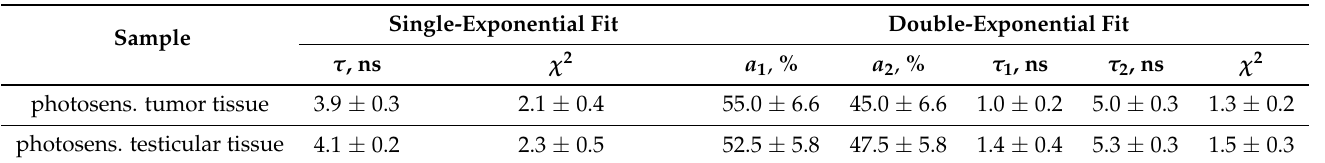
Table 1. Characteristic decay times and amplitudes of fluorescence determined by the single- and double-exponential